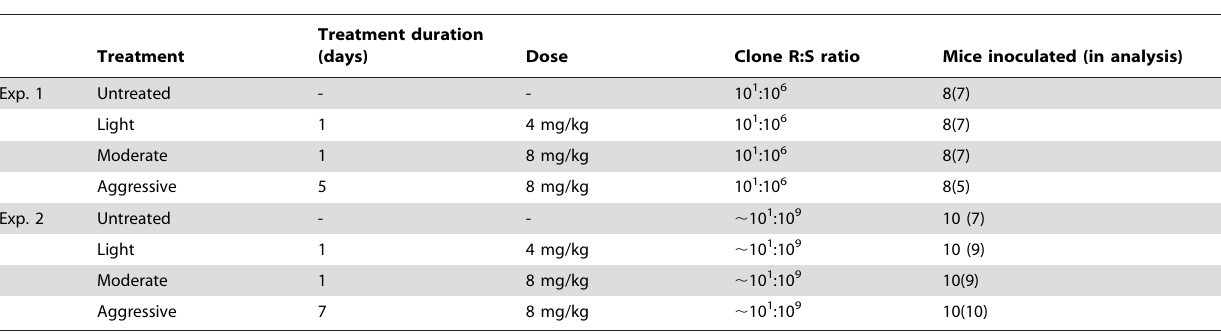
Table 1. Experimental setup of mixed infection of experiments 1 and 2.